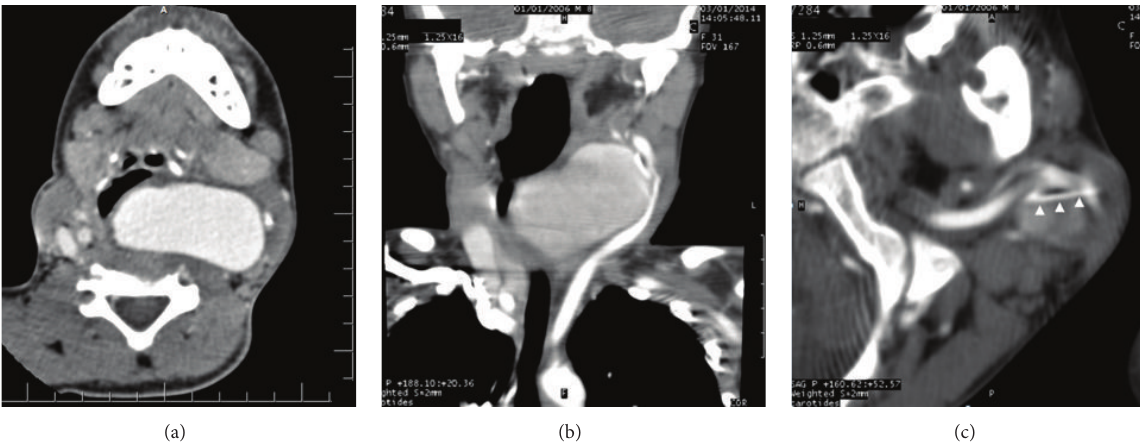
Figure 1: Axial (a) and coronal reformatted (b) contrast-enhanced CT scan images of the neck showing a saccular dilatation of the left common carotid artery with mass effect on the trachea and adjacent vascular structures. Axial bone window image (c) along the upper portion of the aneurysm shows a linear hyperdensity denoted with arrow-heads (later confirmed to be a fish bone).